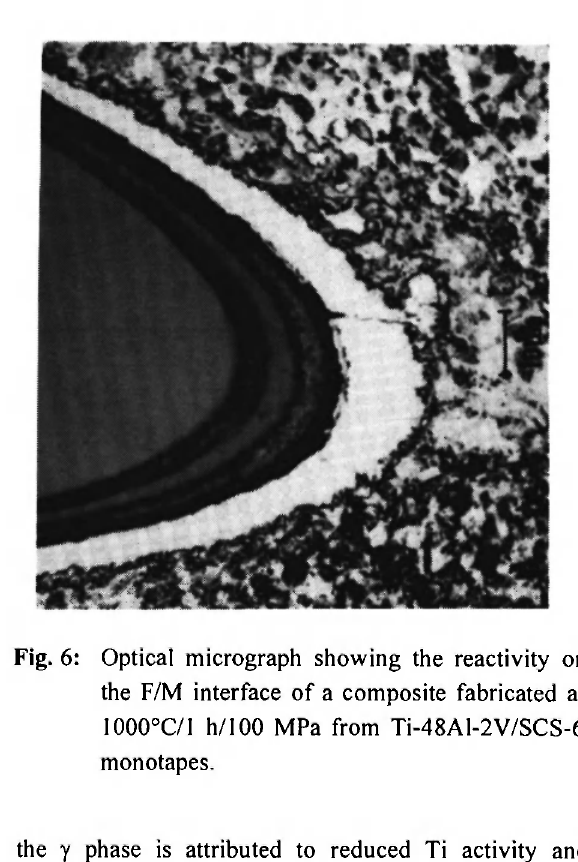
Fig. 6: Optical micrograph showing the reactivity on the F/M interface of a composite fabricated at monotapes.